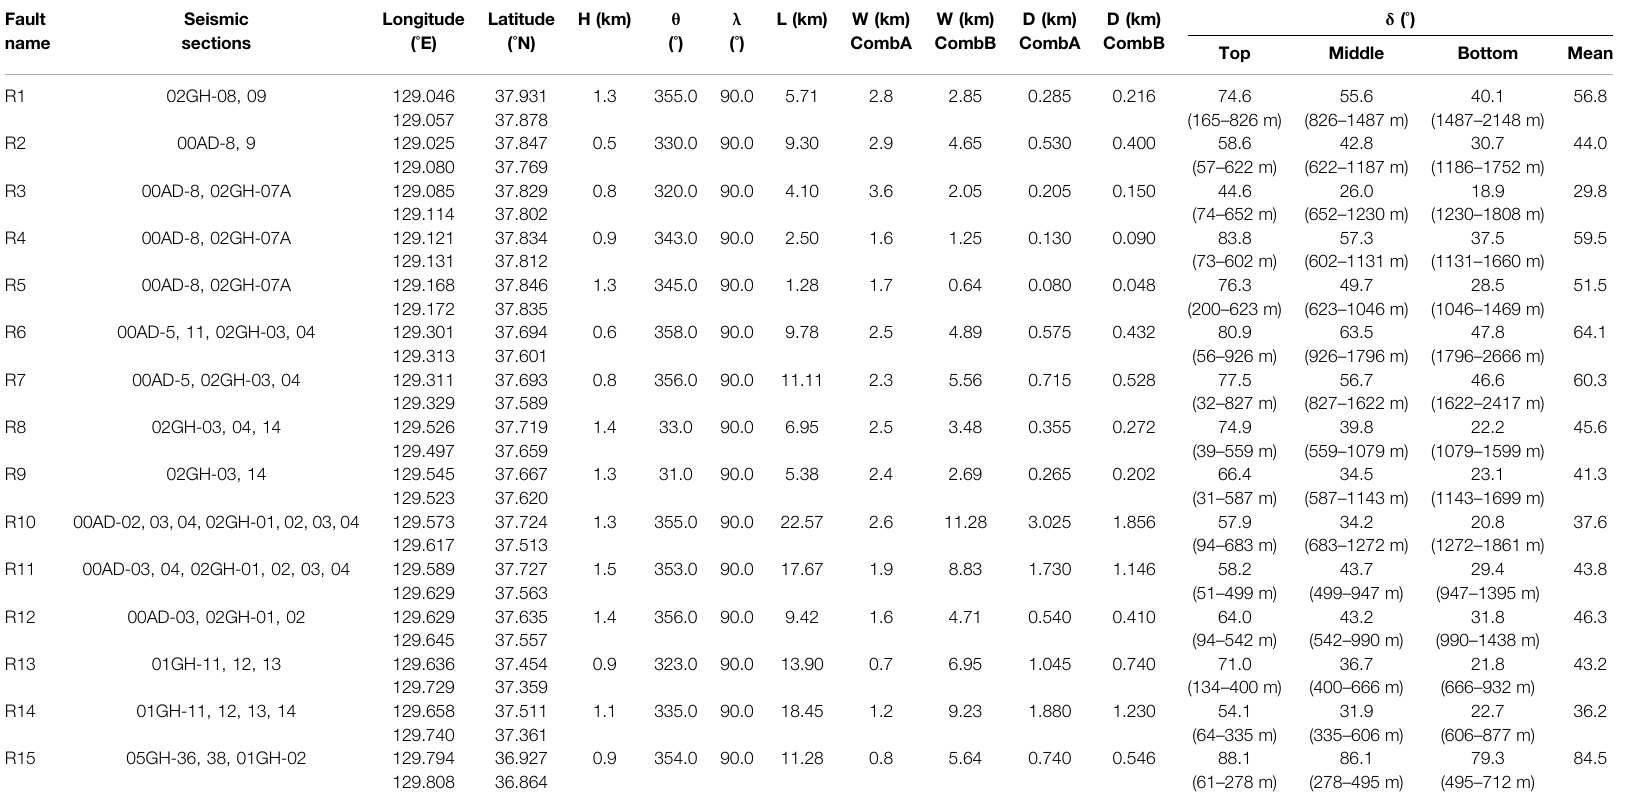
TABLE 1 | Fault parameter scenarios corresponding to the major East Sea fault zones. The de fi nitions of these parameters are referred to Figure 2 . Fault